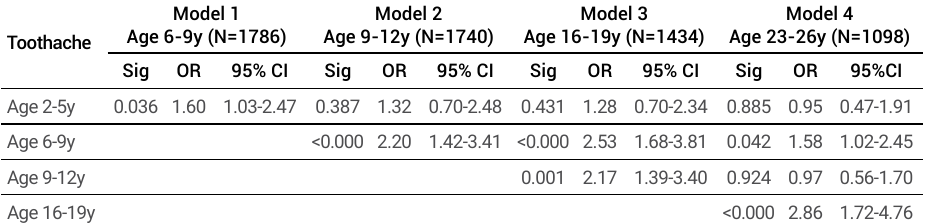
Table 3. Regression model of the association between previous toothache experience and later toothache experience